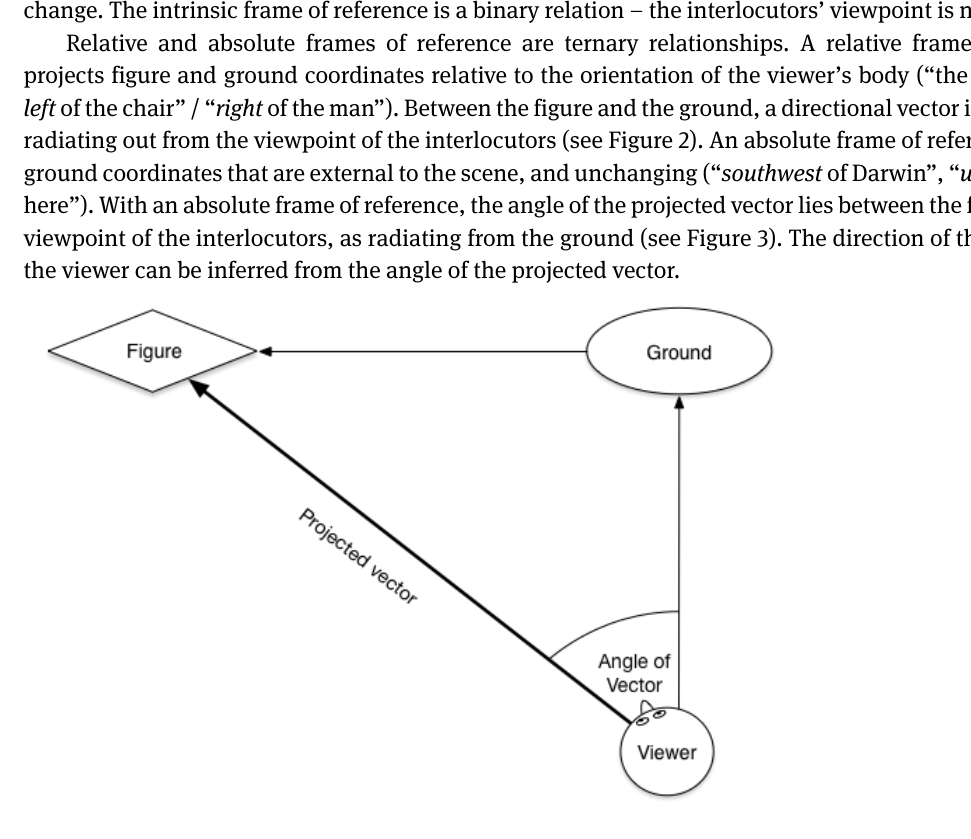
Figure 2: Vector projection within a relative frame of reference (e.g., the Figure is to the left of the Ground). In the event that a place reference is constructed relative to the location of the speech event (i.e., where the viewpoint of the interlocutors is the ground location), then a deictic vector is inferred relative to the orientation of the interlocutors. One way to convey this vector is by pointing. From its source (the origo), the pointing gesture (hereafter ‘point’) projects a trajector toward the figure – interpreted as the target of the point – thus providing the vector of the trajectory (see Figure